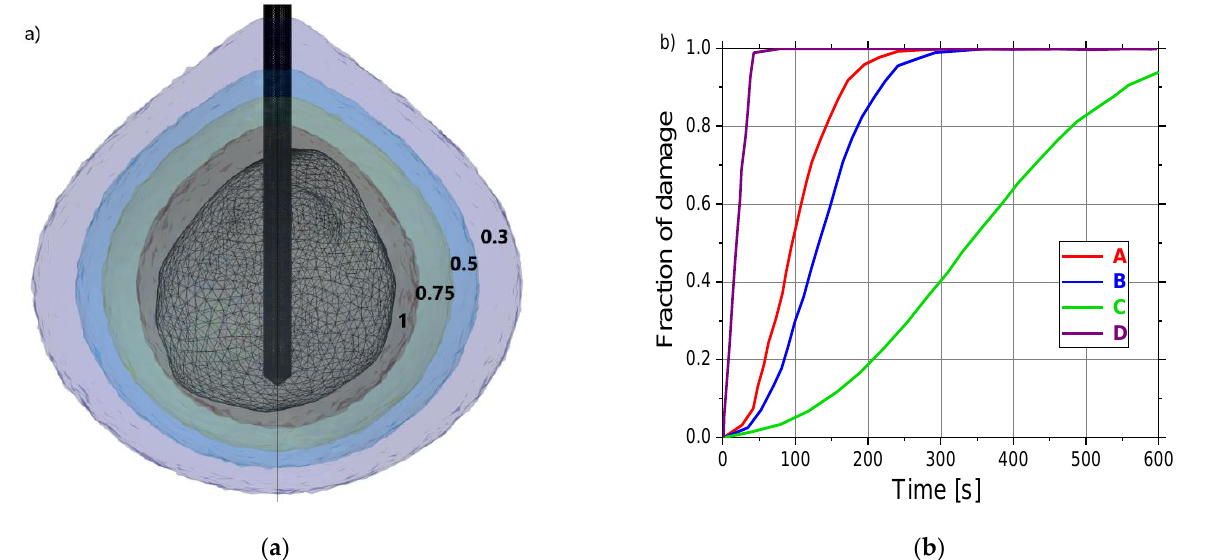
Figure 11. ( a ) The liver tumor [70] is shown as triangulated surface and isocontours corresponding to the fractions of damage of 0.3 (violet), 0.5 (blue), 0.75 (dark green), and 1 (dark gray). ( b ) The time evolution of the necrotic tissue was calculated at four test points (A, B, C, and D) marked in Figure 4b.